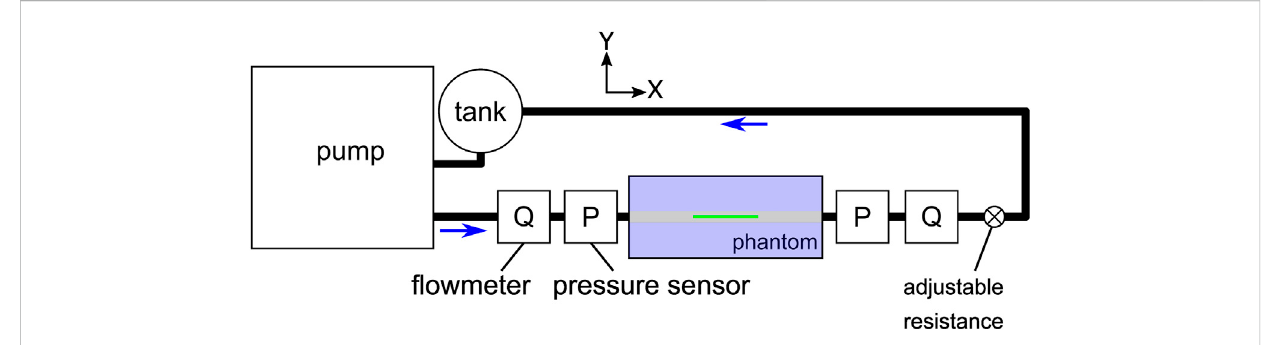
FIGURE 3 Circulation con fi guration for PIV